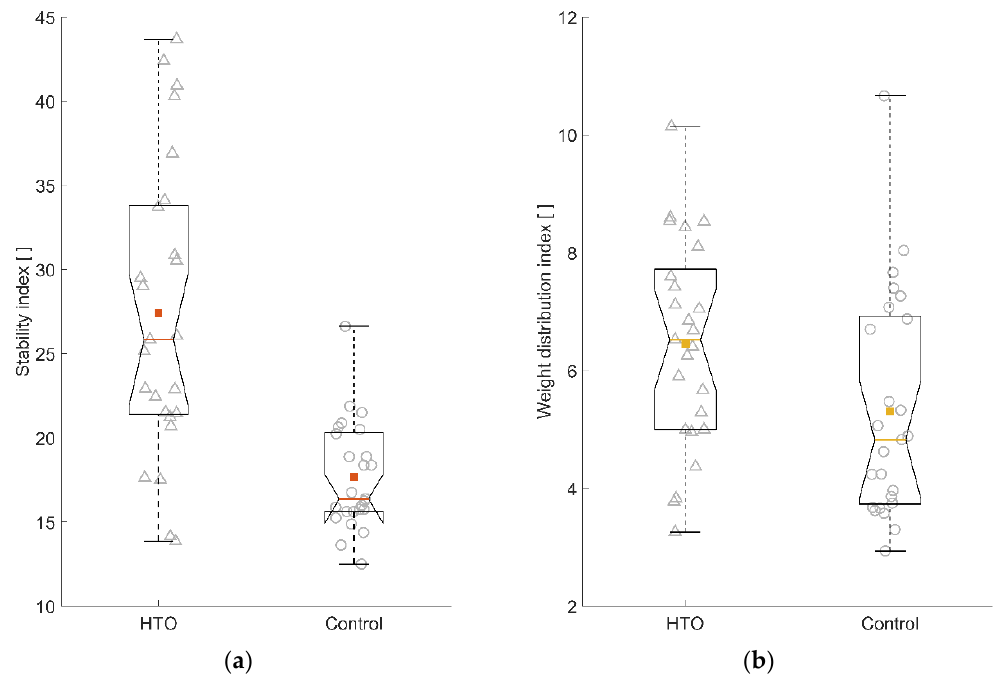
Figure 2. Box-whisker plots on the baseline ( a ) stability index and ( b ) weight distribution index data between the patients selected for high tibial osteotomy (HTO) surgery and matched controls with individual data points. The square symbol in the box denotes the mean of the group data. Higher values indicate greater standing unsteadiness and asymmetry, respectively. (cid:52) , HTO individual